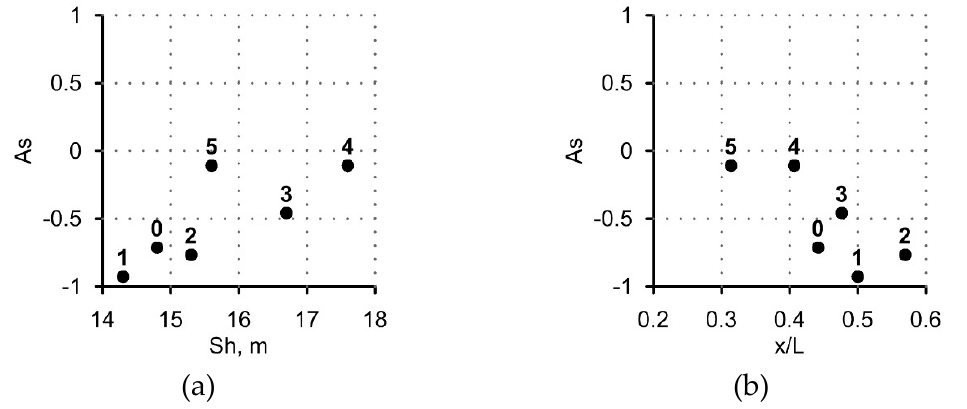
Figure 10. Dependence of ( a ) shoreline retreat (Sh, m) and ( b ) the relative distance of seaward sediment transport (x/L) on wave asymmetry (As) after wave transformation (near the shore, at the x-coordinate 820 m). L is the wavelength calculated for deep-water conditions, and x is the distance of maximal sediments transported away from the shore.